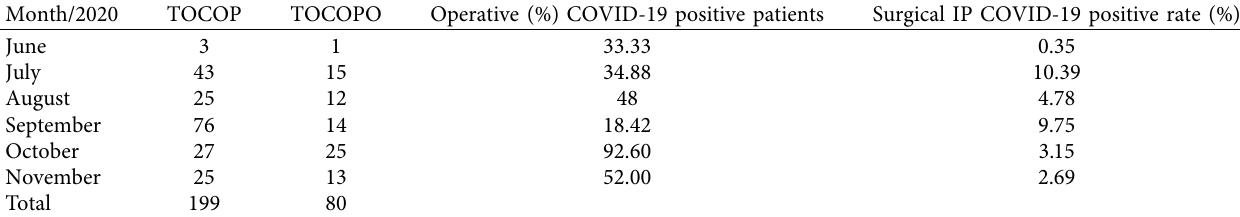
Table 6: Operative percentage of COVID-19 positive patients.